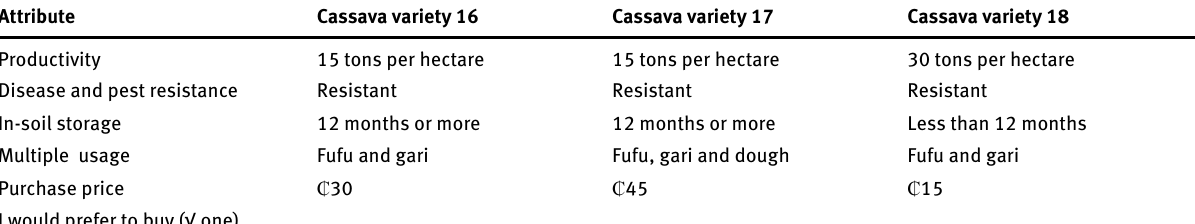
Table 2: An example of a choice set. Assuming that the following cassava varieties were your ONLY choices, which one would you prefer to plant?